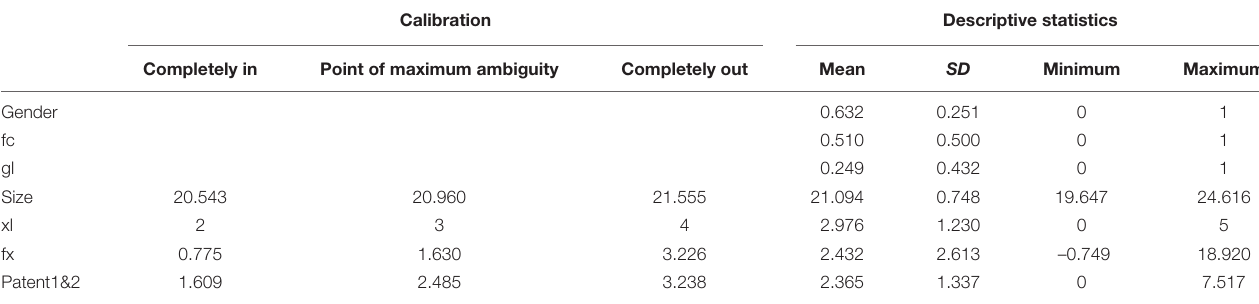
TABLE 3 | Innovation output calibration and descriptive statistics.